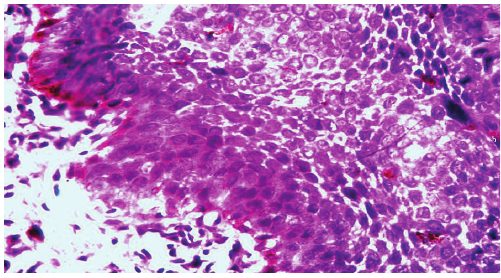
Figure 3: Melanin pigment seen in upper and basal epithelial cell layers. (HE stain, magnification